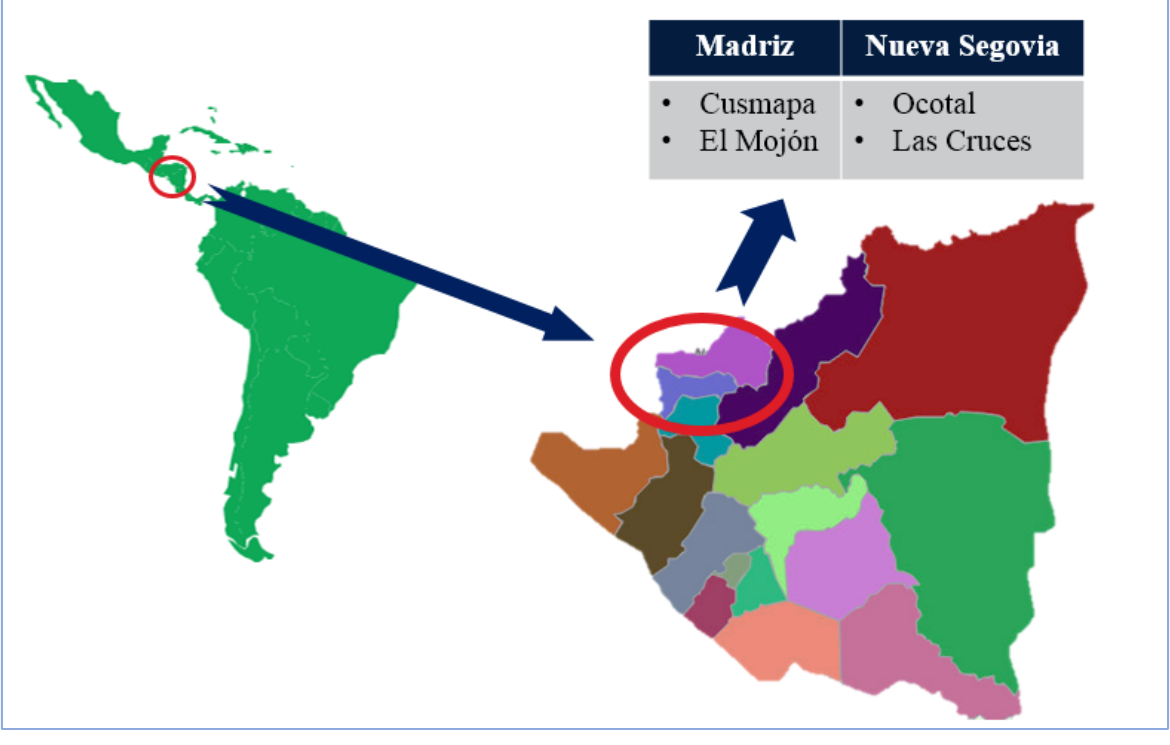
Figure 2: Area of the